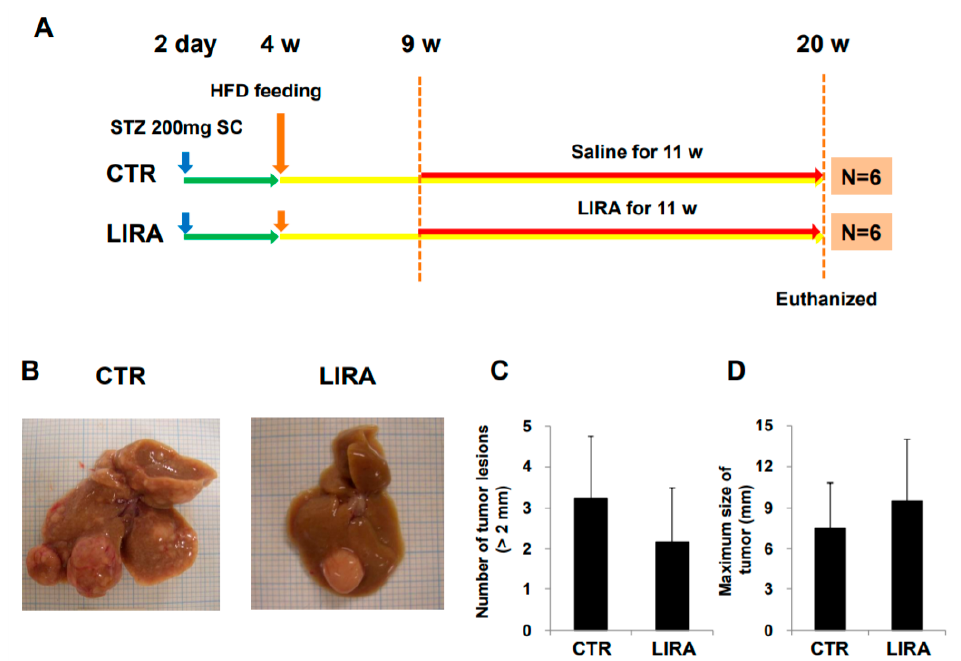
Figure 6. Effect of delayed treatment with liraglutide on hepatocarcinogenesis. ( A ) Experimental design and protocol. A total of 200 µg streptozotocin was injected into 15-day-old male mice at 2 days after birth followed by feeding with a high-fat diet after 4 weeks (w) of age. Mice were killed at 20 w of age ( n = 6/group). Mice were treated with liraglutide (LIRA) or saline (CTR) for 11 w starting at 9 w of age and were killed at 20 w of age. ( B ) Macroscopic image of the liver surface. The total number of tumor lesions ( C ) and maximum size ( D ) of tumors in the liver were compared between the groups. CTR: control mice; LIRA: liraglutide-treated mice; STZ: streptozotocin; SC: subcutaneous injection; HFD: high-fat diet.